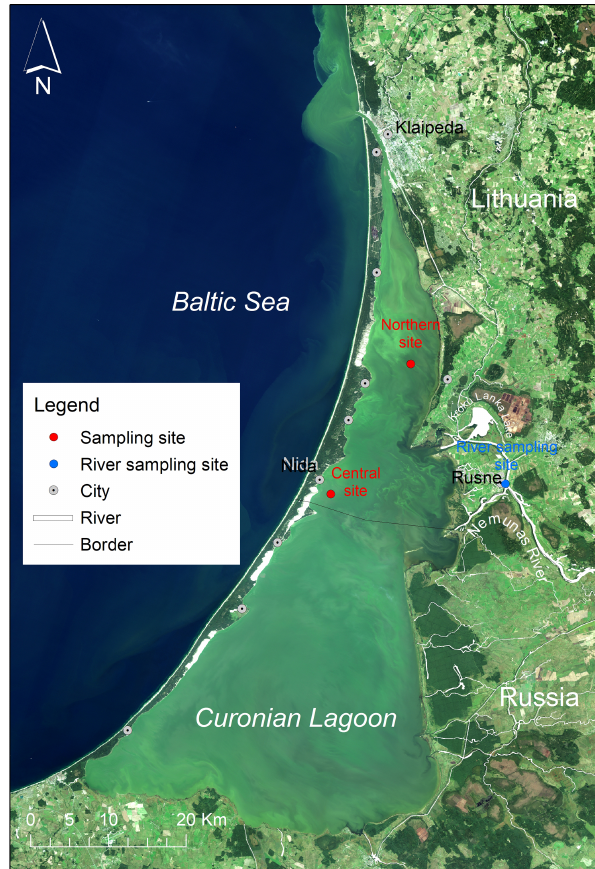
Figure 1. Satellite image by OLI/Landsat-8 (18 September 2014) showing summer blooms in the Curonian Lagoon with the sam- pling sites (red circles) representing the northern and south-central regions, and monitoring site at the Nemunas river (blue circle). LT = Lithuania, RUS = Russia, and the black line indicates a border between the two